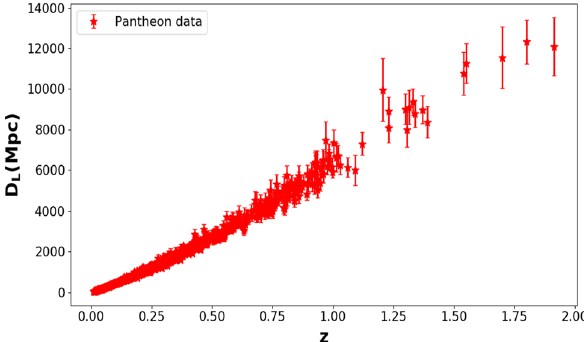
Fig. 2 The luminosity distance D L , of full Pantheon (Type Ia SNe) sample as a function of redshift. For this plot we have assumed M B = − 19 . 253 ± 0 . 027